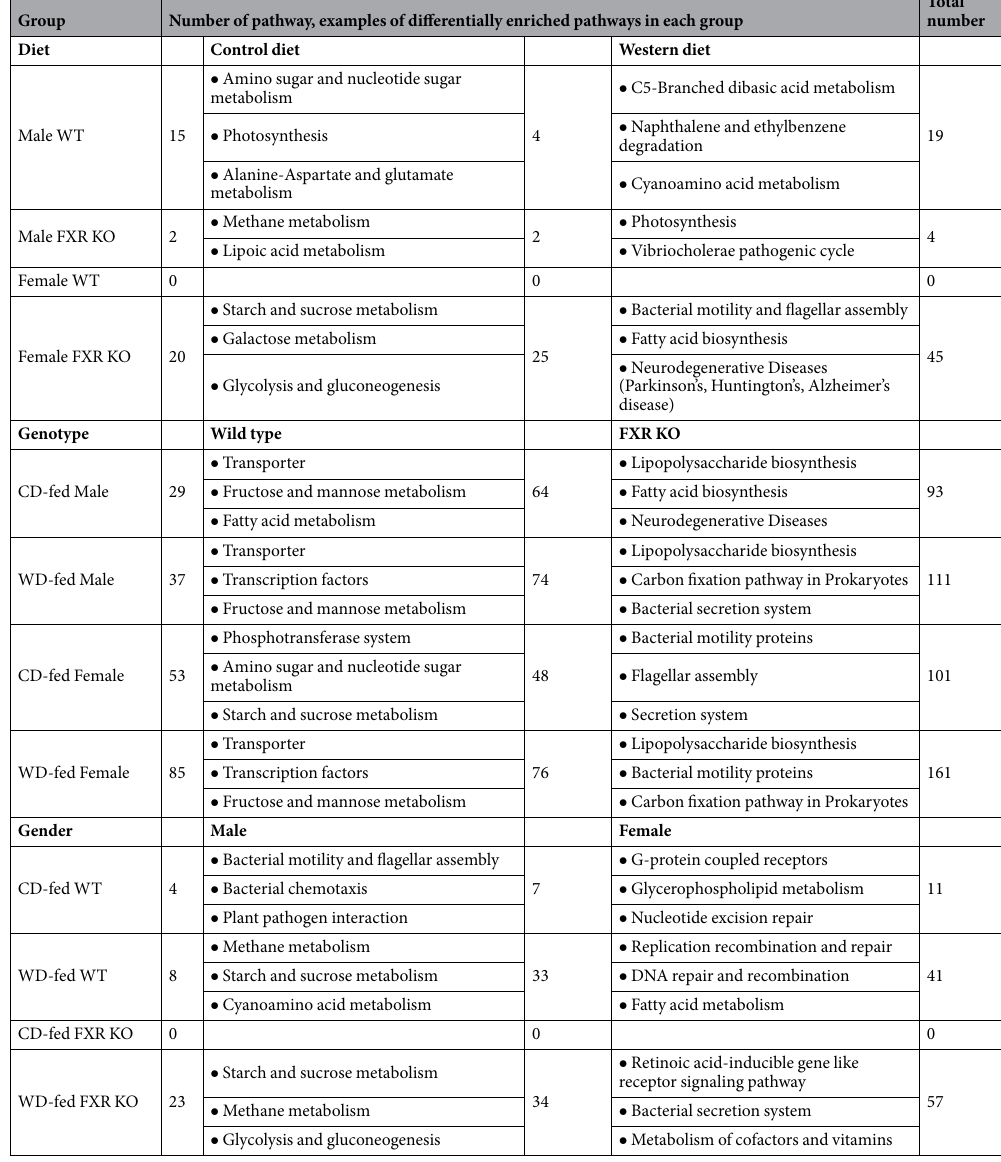
Table 1. Differentially enriched microbial pathways in each